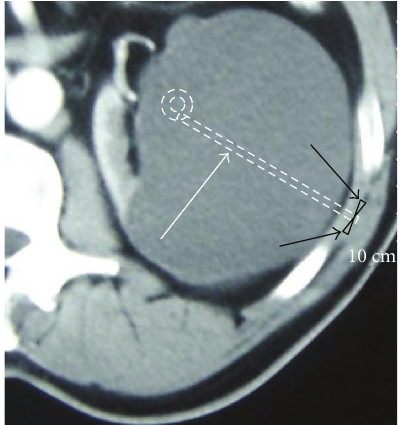
Figure 3: Schematization of CRS technique. Black arrows: sutures at two di ff erent sites. White arrow: CRS-catheter after the introducer needle taken out.